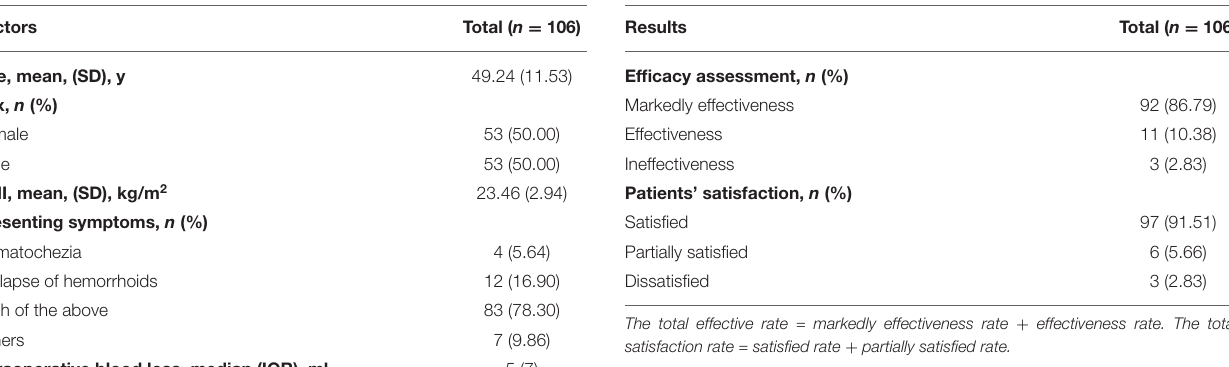
TABLE 1 | Patient demographics and clinical characteristics. TABLE 2 | Efficacy assessment and patient